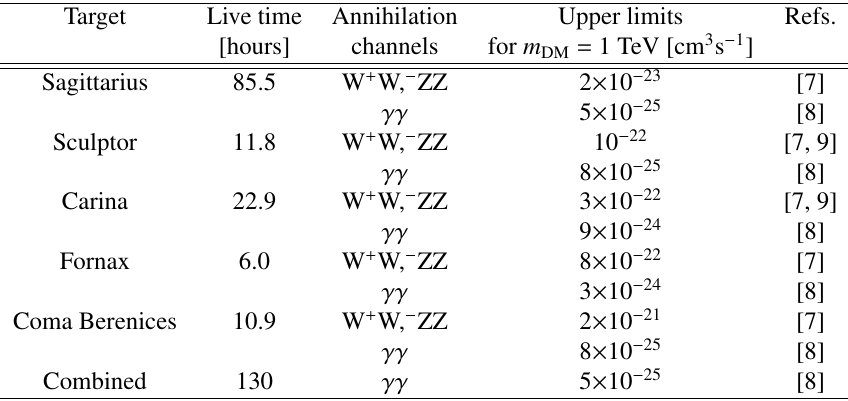
Table 1. Upper limits on (cid:2) σv (cid:3) towards classical and ultra-faint dSphs observed by H.E.S.S. The fourth column provides a round value value of the upper limits at 95% C.L. extracted from references given in the fifth column. Target Live time Annihilation Upper limits Refs. [hours] channels for m DM = 1 TeV [cm 3 s − 1 ]